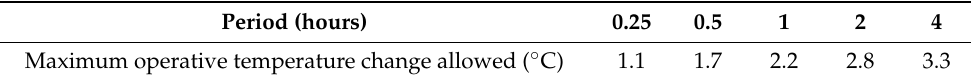
Table 4. The limits on temperature drifts and ramps (ASHRAE,